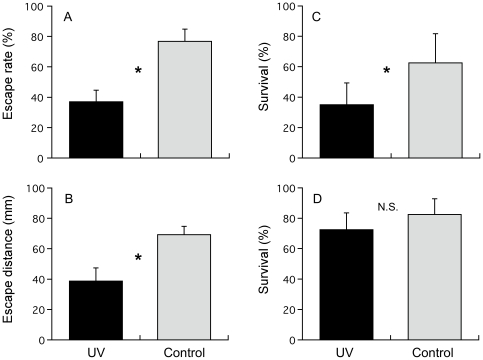
Effects of UV-B on escape performance from a predator and survival of cod larvae (Gadus morhua).A: Mean escape rate of cod larvae against two-spotted goby (Gobiusculus flavescens). B: Mean escape distance of cod larvae against two-spotted goby. C: Mean survival of cod larvae against two-spotted goby. D: Mean survival of cod larvae against lion's mane jellyfish (Cyanea capillata). Cod larvae in the UV-B treatment showed poorer escape rate, escape distance and survival against goby compared to that of Control. There was no significant difference between treatments was found in the survival of cod larvae against jellyfish. Asterisks indicate a significant difference between UV-B treatment and Control (P<0.05). Vertical bars are standard deviations.